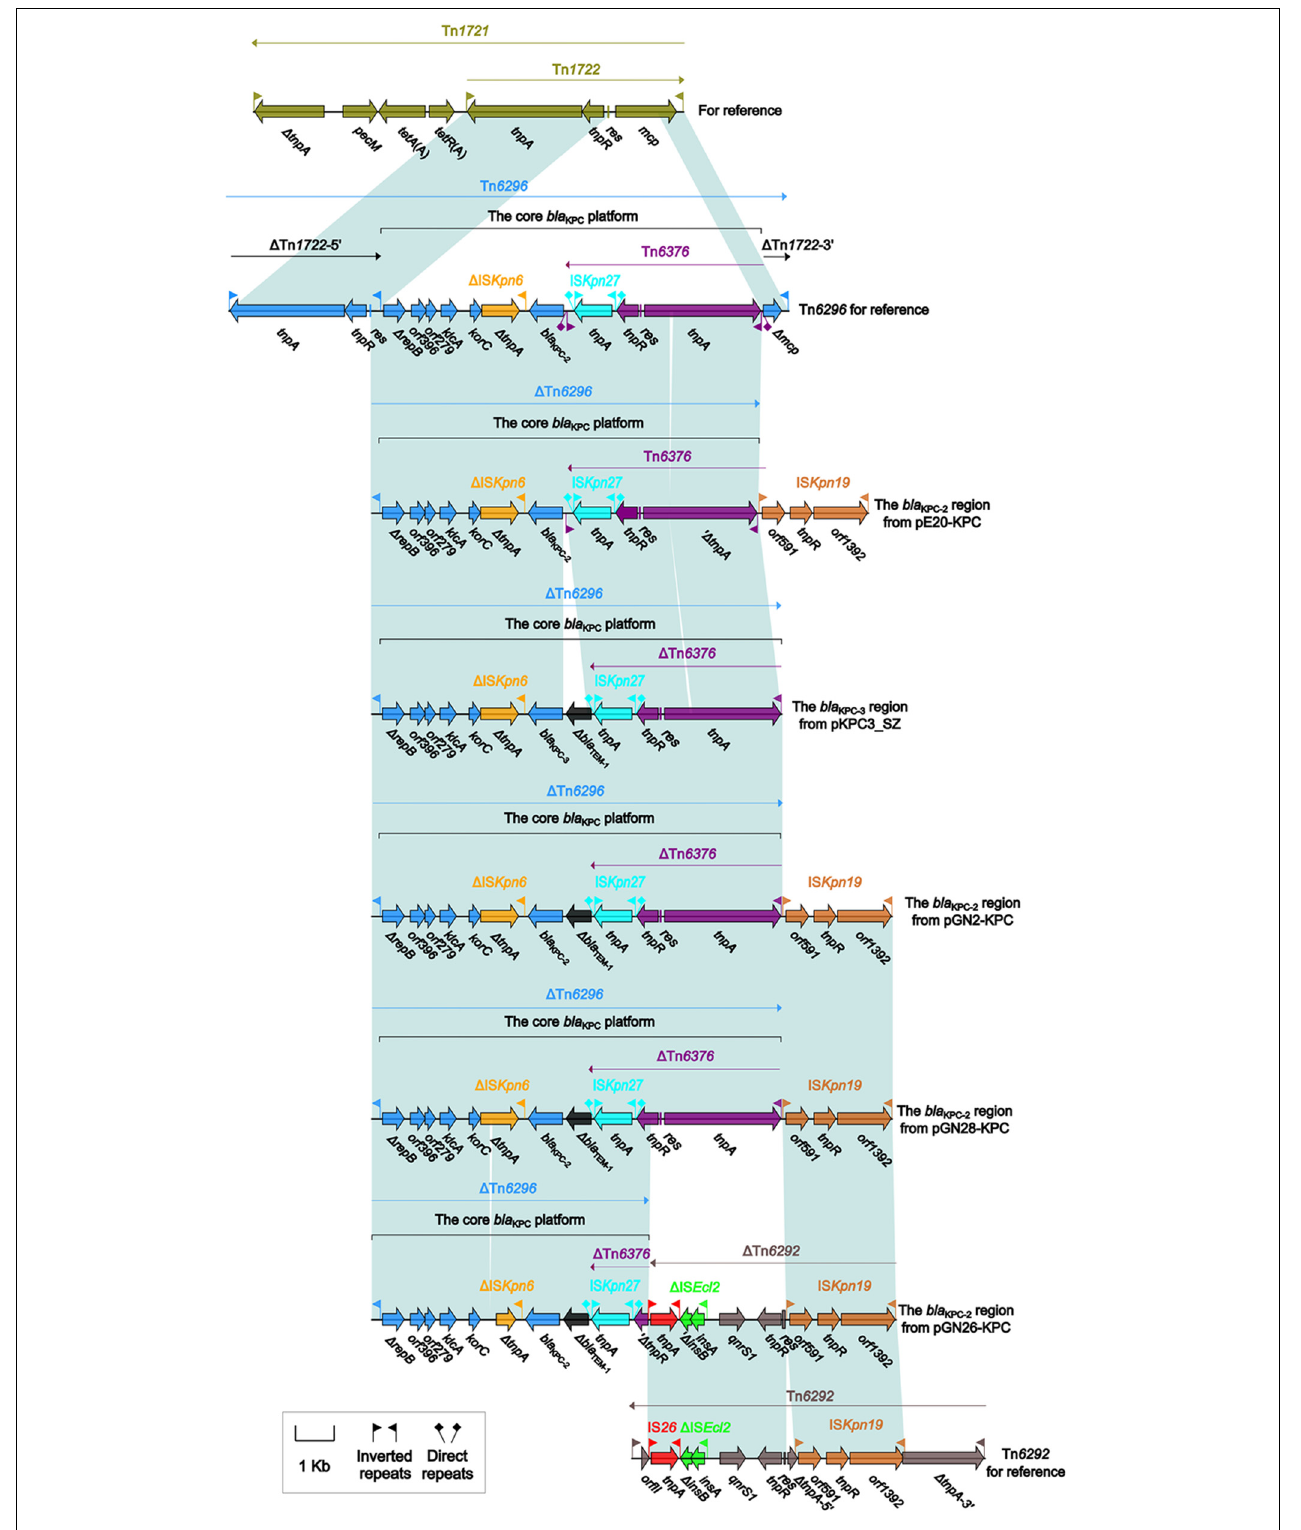
FIGURE 2 | The bla KPC regions from IncX6 plasmids, and comparison with related regions. Genes are denoted by arrows. Genes, mobile elements, and other features are colored based on function classification. Shading denotes regions of homology ( > 95% nucleotide identity).